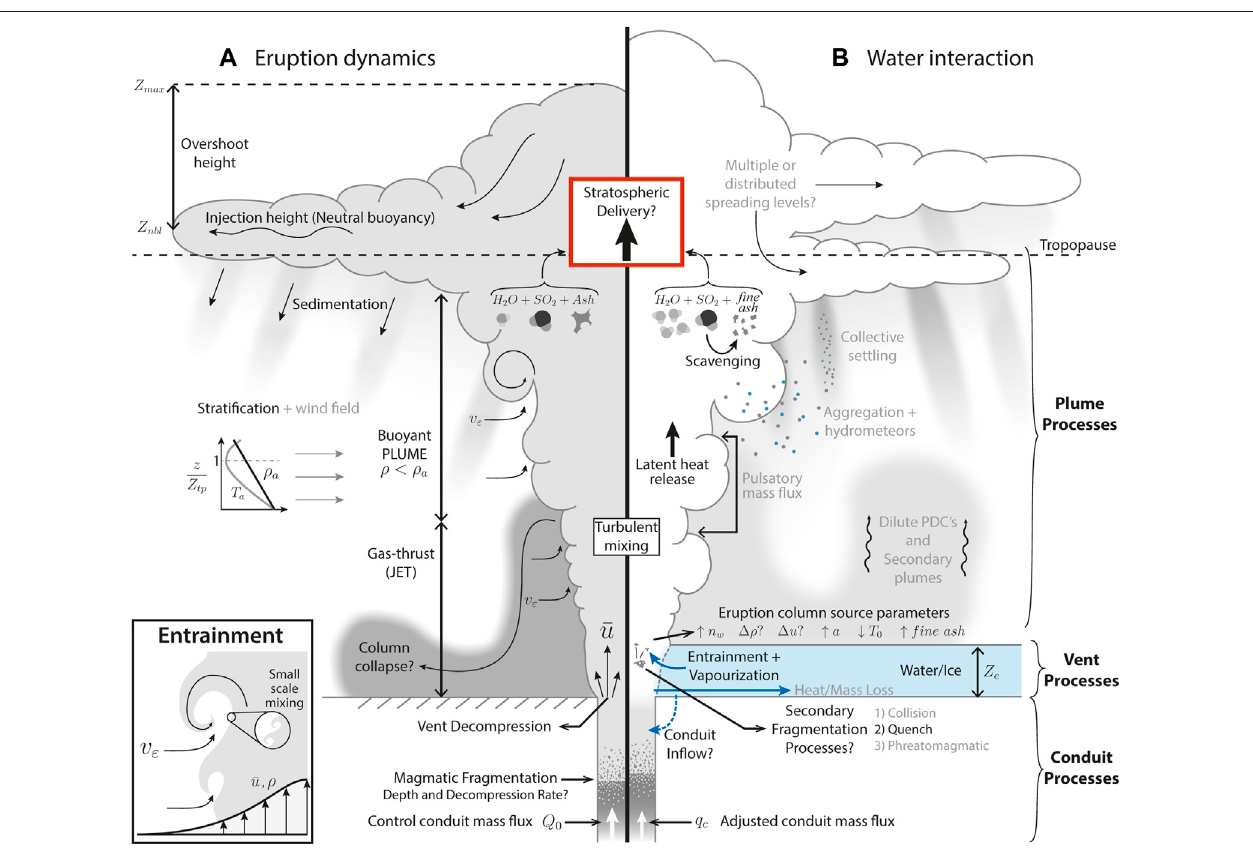
FIGURE 1 | Summary of eruption processes from conduit to atmospheric dispersal. See text for a description of processes and their relevance for SO 2 transport. See Table 1 for acomplete description of symbols. (A) Dynamical processes during a sustained, “ dry ” Plinian eruption. Inset: illustration of the entrainment process. (B) Summary ofprocesses in fl uenced by surface water interaction during a hydrovolcanic eruption. Processes in lighter gray text are those not considered in this study, but which are relevant to hydrovolcanic eruptions processes and may play a role in stratospheric delivery of SO 2 .